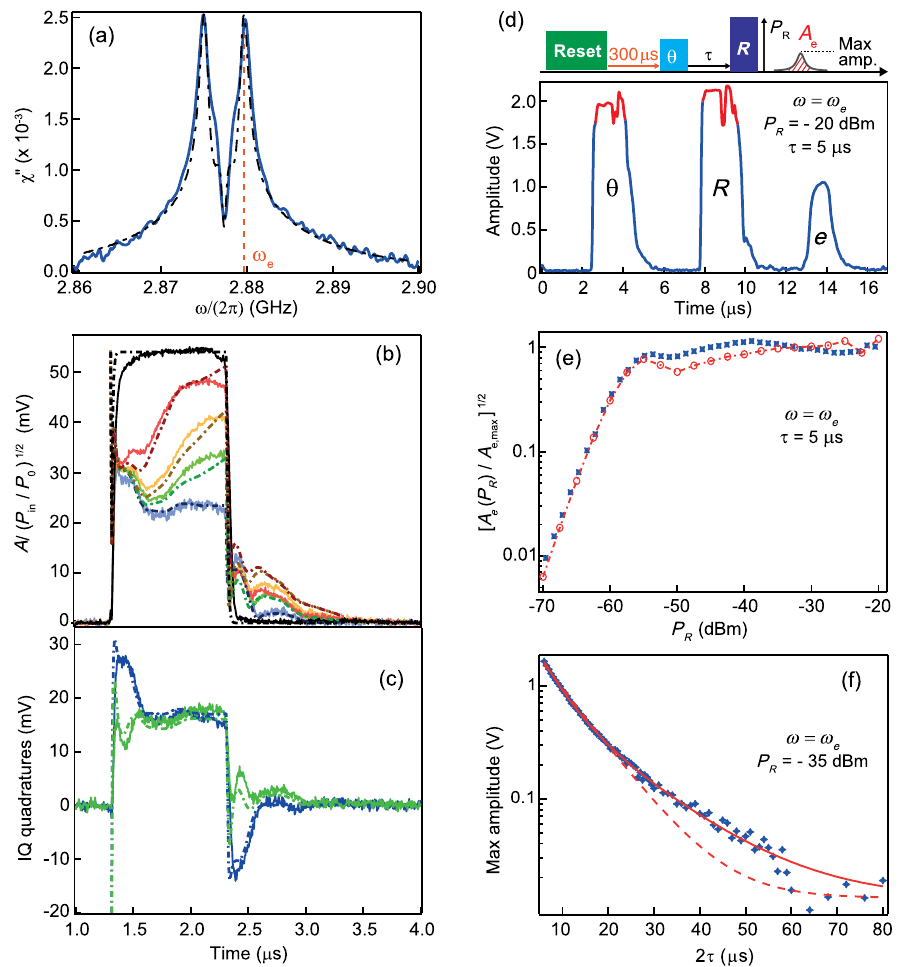
¼ 0 mT. The NV ¼ − 90 , − 60 , − 55 , and − 50 dBm (blue, . Solid lines are experimental data with P in in ffiffiffiffiffiffiffiffiffiffiffiffiffiffi p P =P for easier comparison, with P 0 ¼ − 90 dBm. 0 in ¼ − 90 dBm. (d) Spin-echo sequence. An incoming in ¼ 4 . 7 μ s and T ¼ 14 . 3 μ s, 2 A 2 B